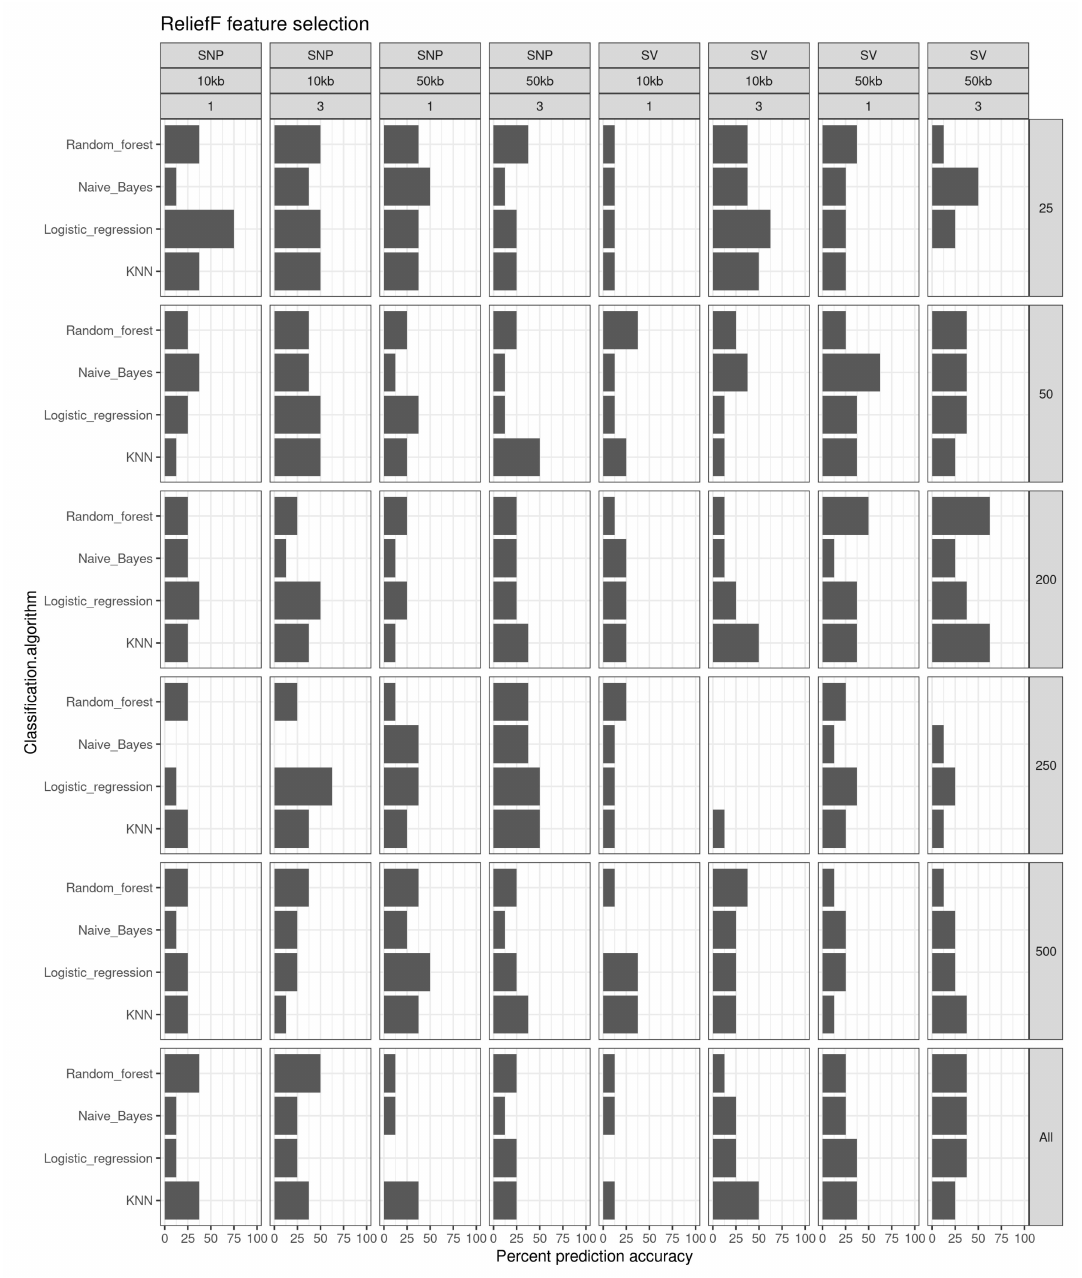
Figure 6. Prediction accuracy (%) for the different feature selection sets of classification algorithms using a ReliefF feature selection